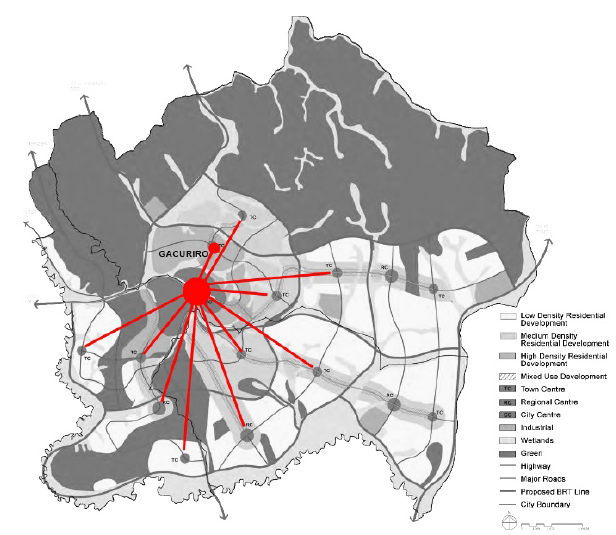
Figure 3. Kigali City Master Plan 2013. Drawing by Manlio Michieletto, adapted from Surbana International Consultants